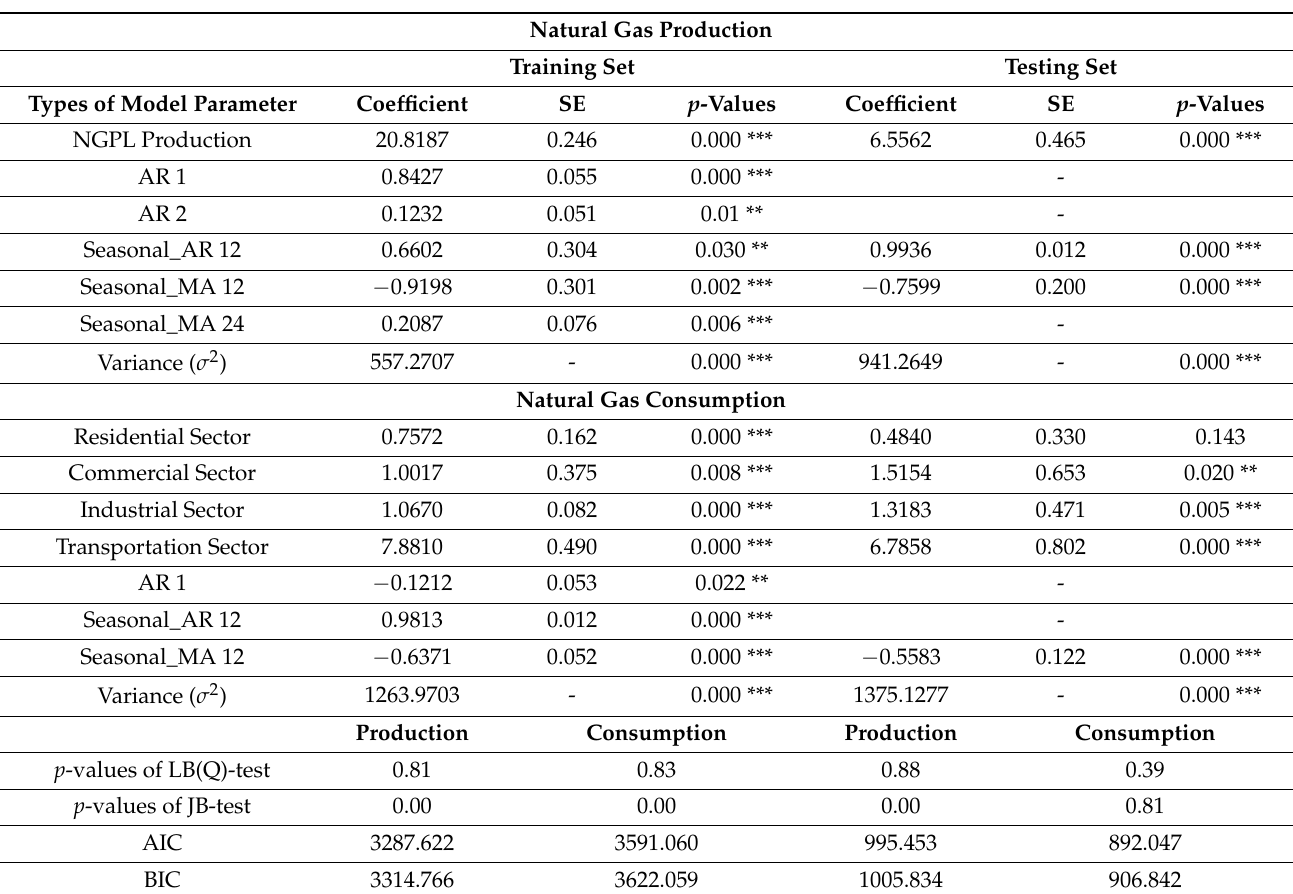
Table 5. Final parameter estimates for the SARIMAX (SARIMA with exogenous variables) model in natural gas production and consumption.